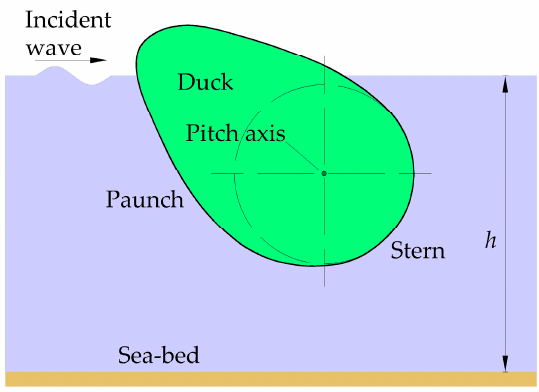
Figure 1. A plain view of the duck cross section.